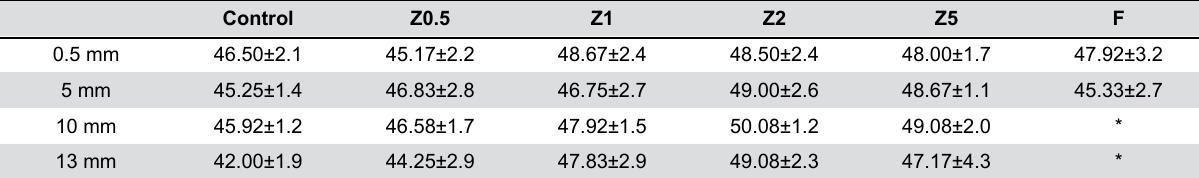
Table 2- Hardness (Shore D Units) of TFMs with ZM at different cure depths (Mean±SD)